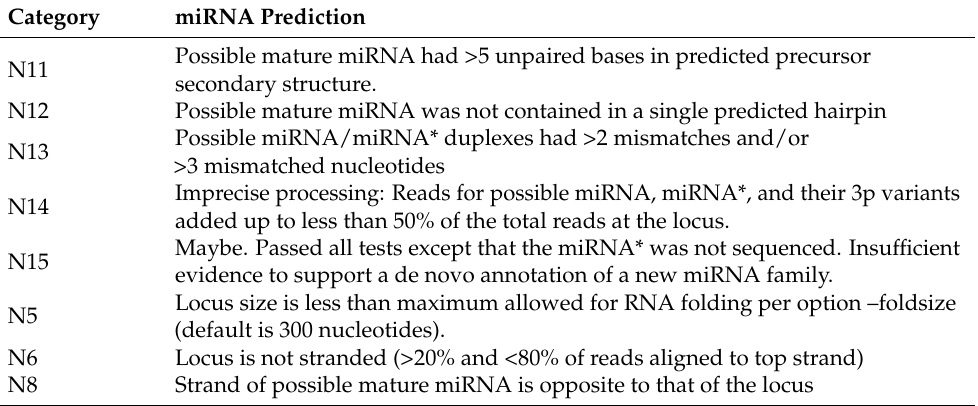
Table 1. miRNA categories assigned Ceratobasidium small RNA loci after analysis by